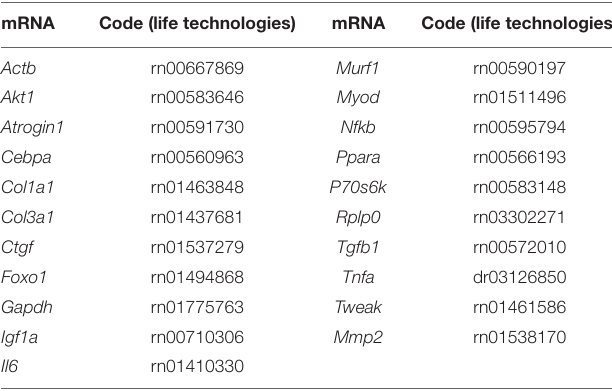
TABLE 1 | List of tested genes associated with extracellular matrix, inflammation, metabolism, and myogenesis.